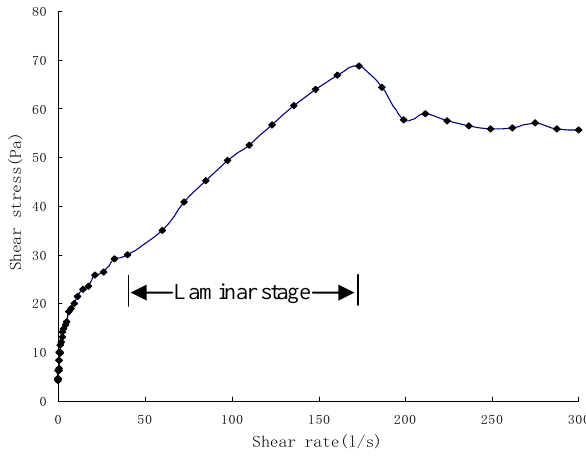
Fig. 6. Rheological curve of debris flow in Figure 6. Rheological curve of debris flow in model